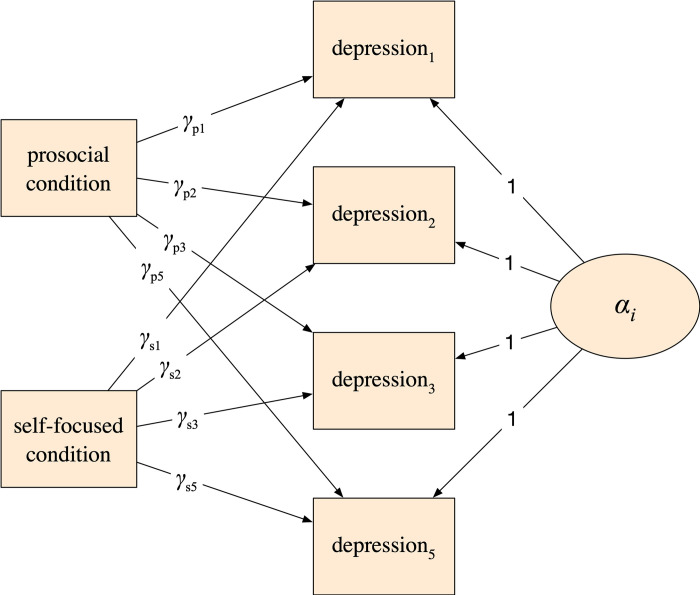
Example of a random intercept model as a structural equation model.Control variables, intercepts, and errors not shown for clarity.